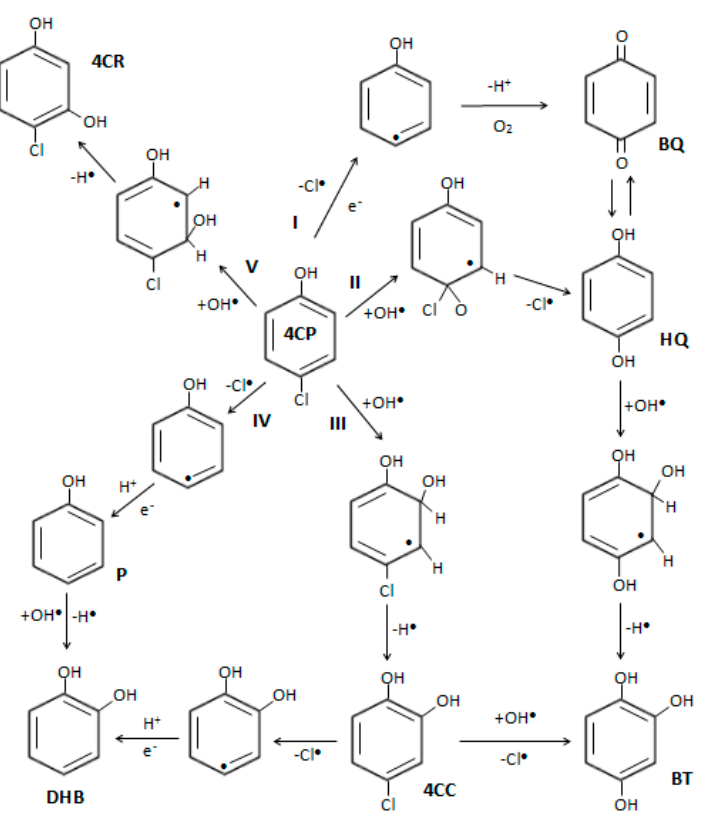
Figure 15. Proposed photocatalytic degradation pathway of 4-chlorophenol by W-Mo-TiO 2 .